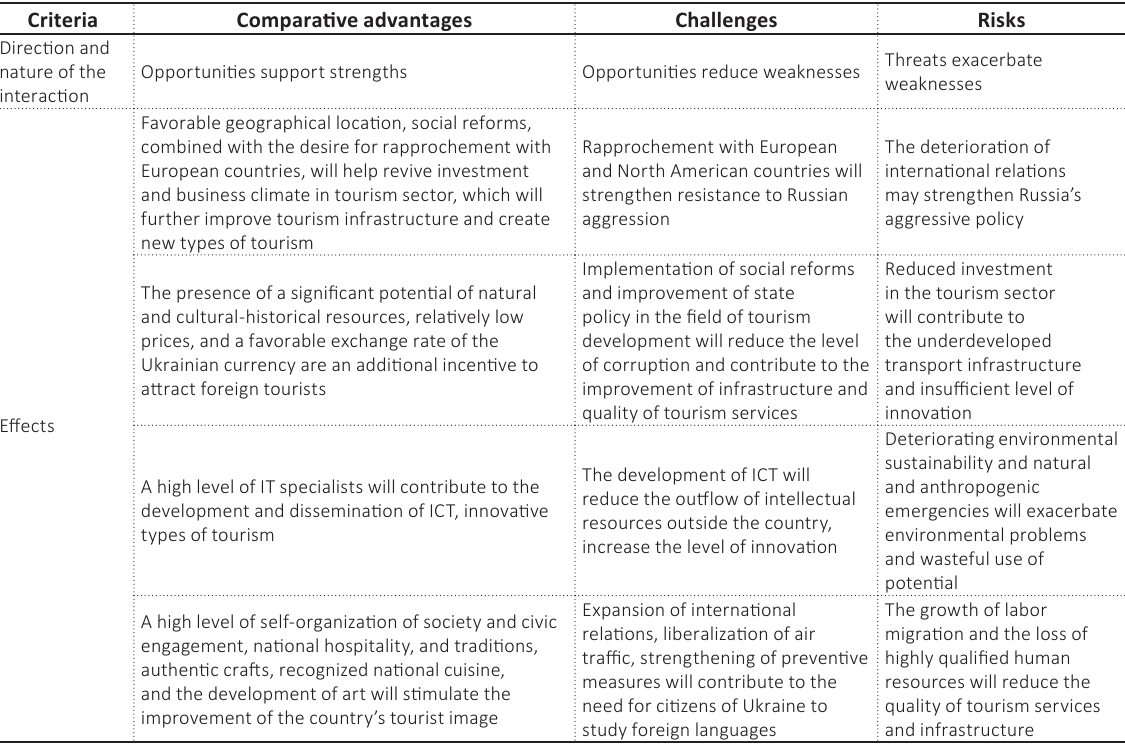
Source: Developed by the authors.